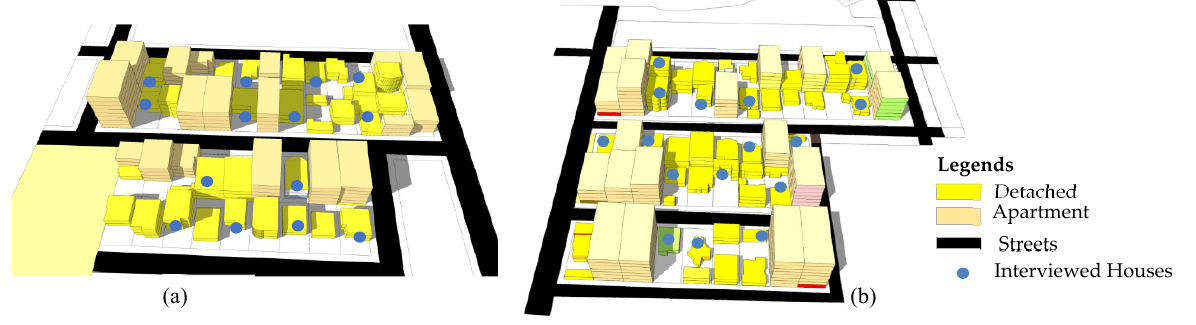
Figure 5. Three-Dimensional Version of Current Condition of Study Areas and Surveyed Houses: ( a ) Parwan-2; ( b ) Taimani.